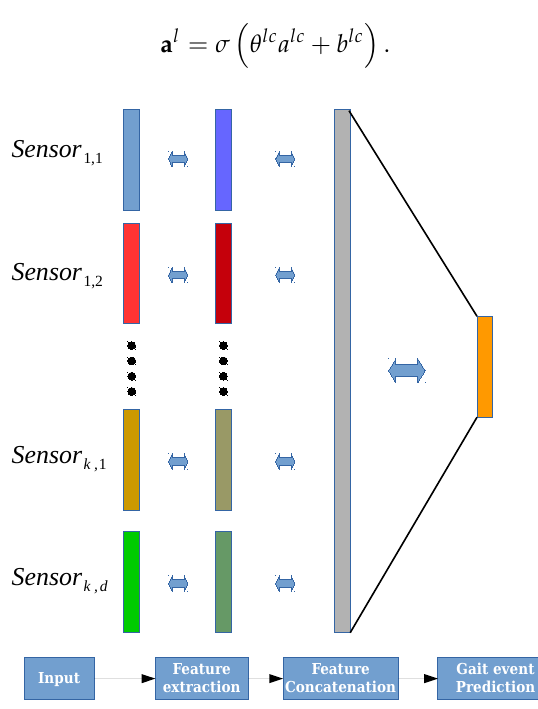
Figure 4. This figure illustrates the exponentially delayed fully connected neural network (ED-FNN) architecture. Initially, the network individually receives each sensor input from the matrix X in Equation (5). Then, the network separately extracts the features of each sensor and concatenates them into a single feature vector. Finally, the output layer uses the feature vector to forecast the gait events of the